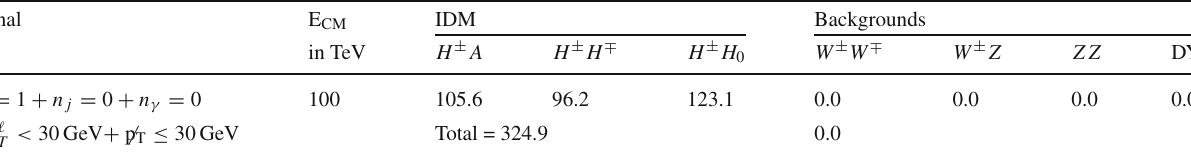
≤ 20GeV signature at center of Mass energy of 100 TeV for the chosen BP of IDM at an integrated luminosity of 1000 Table 4 n (cid:12) = 1 + 5 ≤ p (cid:12) T fb − 1